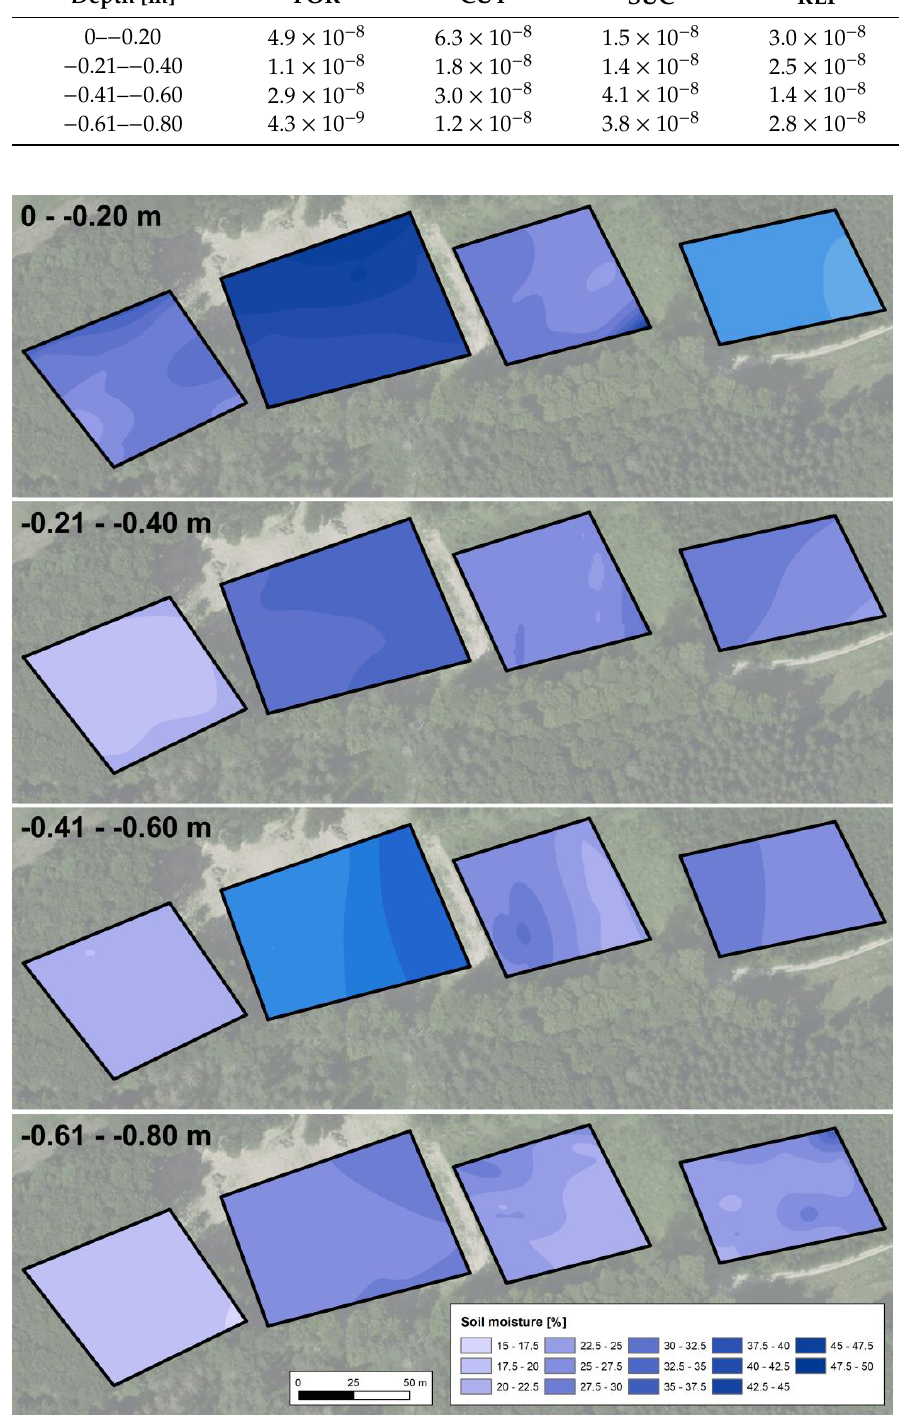
Figure 11. Interpolated soil moisture. Aerial photography provided by LVermGeo RLP (2019).